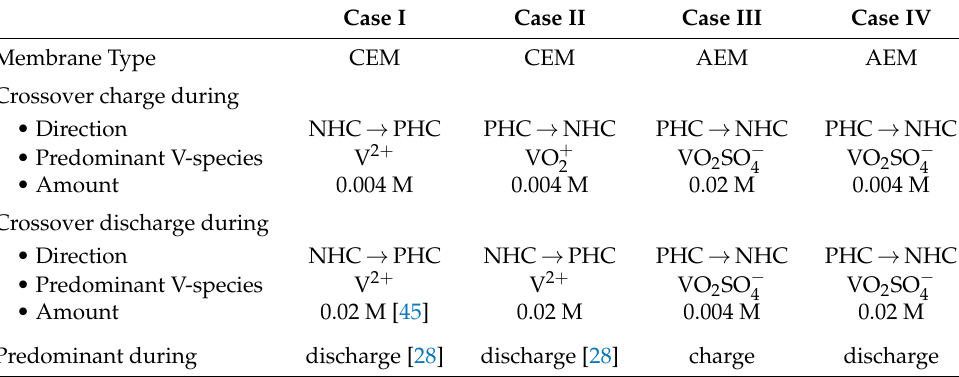
Table 2. Crossover case studies in dependence on membrane type, crossover direction, amount and state of operation. Case I Case II Case III Case IV CEM